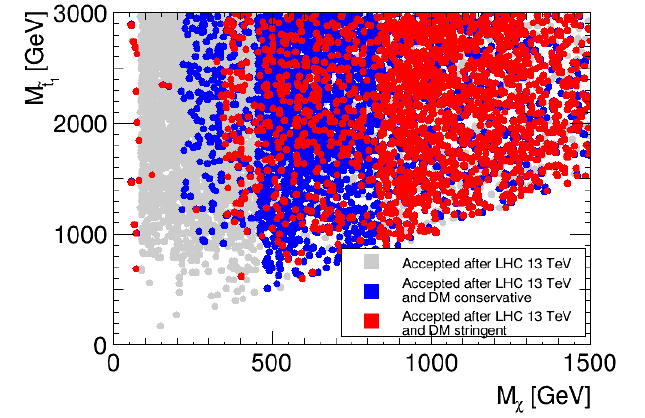
Figure 20 . pMSSM points in the ( M (cid:31) ; M ~ ) parameter plane. The accepted parameter points t 1 which are in agreement with the LHC 8 and 13 TeV data from Higgs and direct searches are shown in gray. The points which in addition agree with dark matter constraints with conservative astrophysical hypotheses are in blue, and with stringent hypotheses in